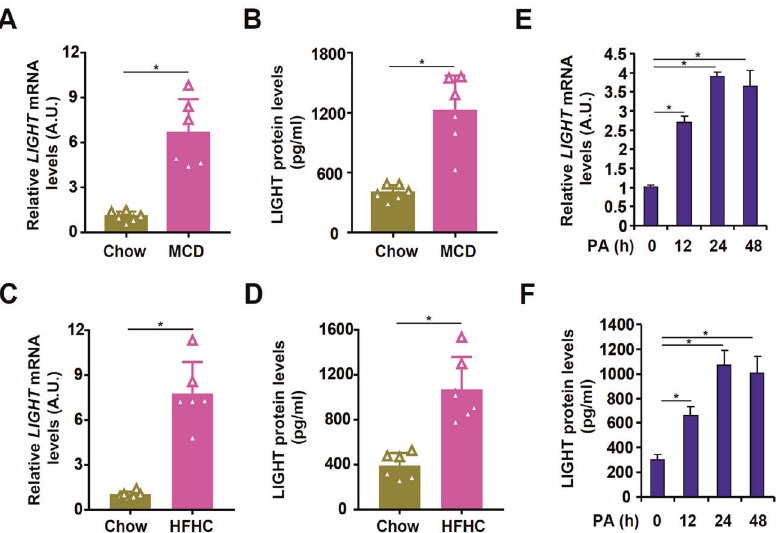
Fig. 1 LIGHT expression is elevated in the pathogenesis of non-alcoholic fatty liver disease. A , B C57B6/L mice were fed an MCD diet for 4 weeks. Hepatic LIGHT expression was examined by qPCR and ELISA. C , D C57B6/L mice were fed an HFHC diet for 12 weeks. Hepatic LIGHT expression was examined by qPCR and ELISA. E , F Primary murine hepatocytes were treated with palmitate (0.3 mM) and harvested at indicated time points. LIGHT expression was examined by qPCR and